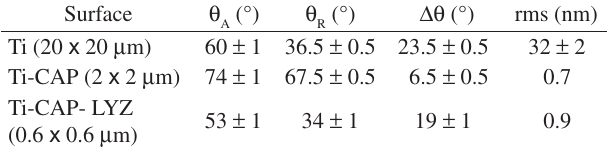
) and receding ( θ A – θ ) and roughness (rms) determined A R